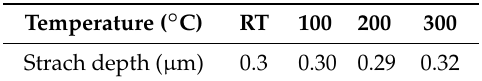
Figure 5. Distribution curves of the depth of nanometer scratches of the length of the slit. Table 4. Average depth of nanometer scratches for the preparation of dense areas of samples at different temperatures.